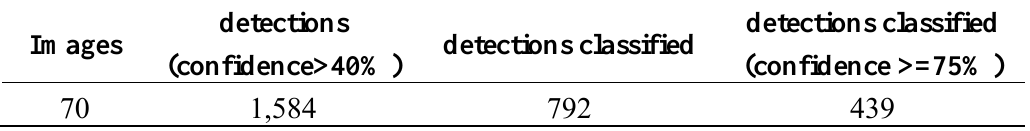
Table 3 . Summary of main detection and classification results for the datasets shown in Figure 10